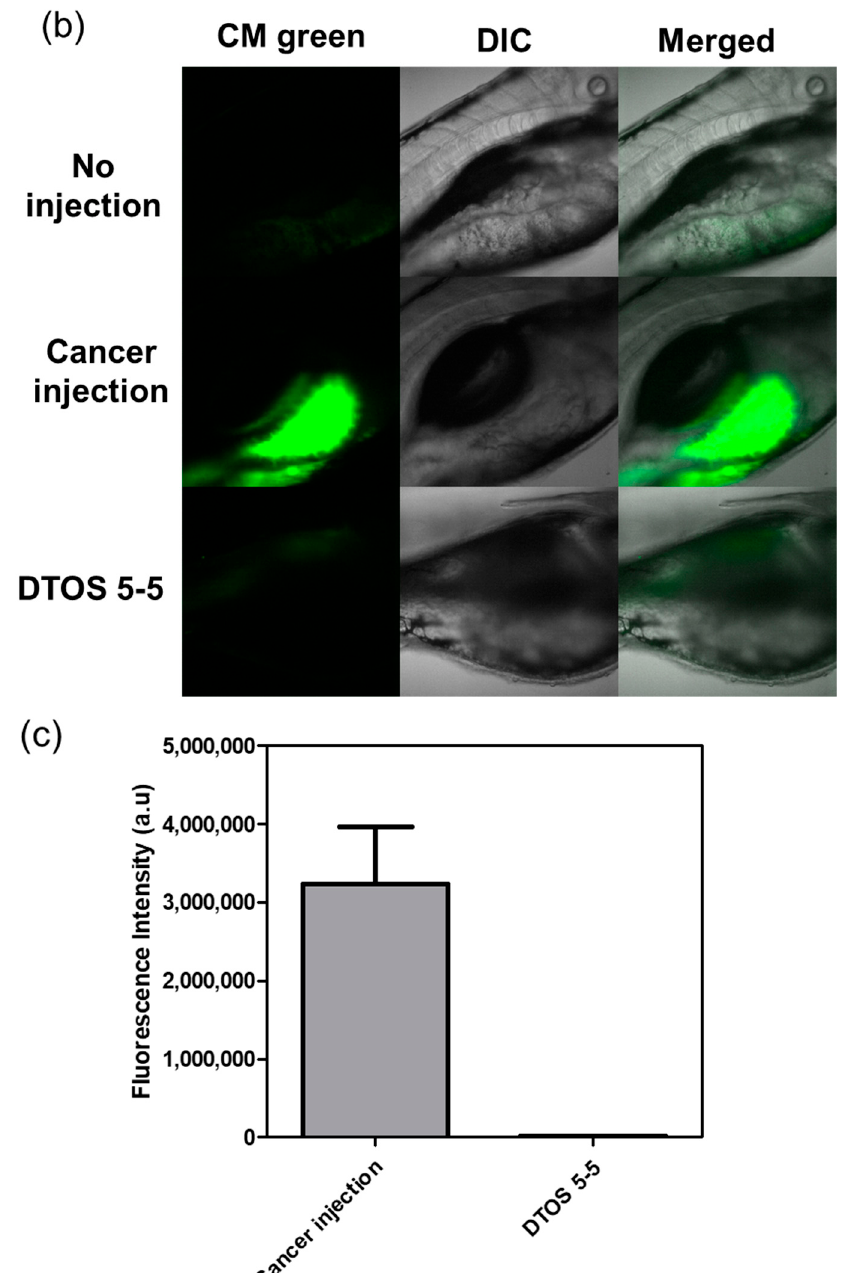
Figure 11. HeLa cells xenografted onto zebrafish larvae. ( a ) Colocalization of the emulsion and cancer cells. ( b ) Anticancer effect of the emulsion on the HeLa cells xenografted onto zebrafish larvae. ( c ) Fluorescence intensity of cell-tracker-labeled HeLa cells in zebrafish larvae. Each value presents the average and standard deviation (n = 3). DIC, differential interference contrast; hpf, hours post-fertilization; hpi, hours post-injection.